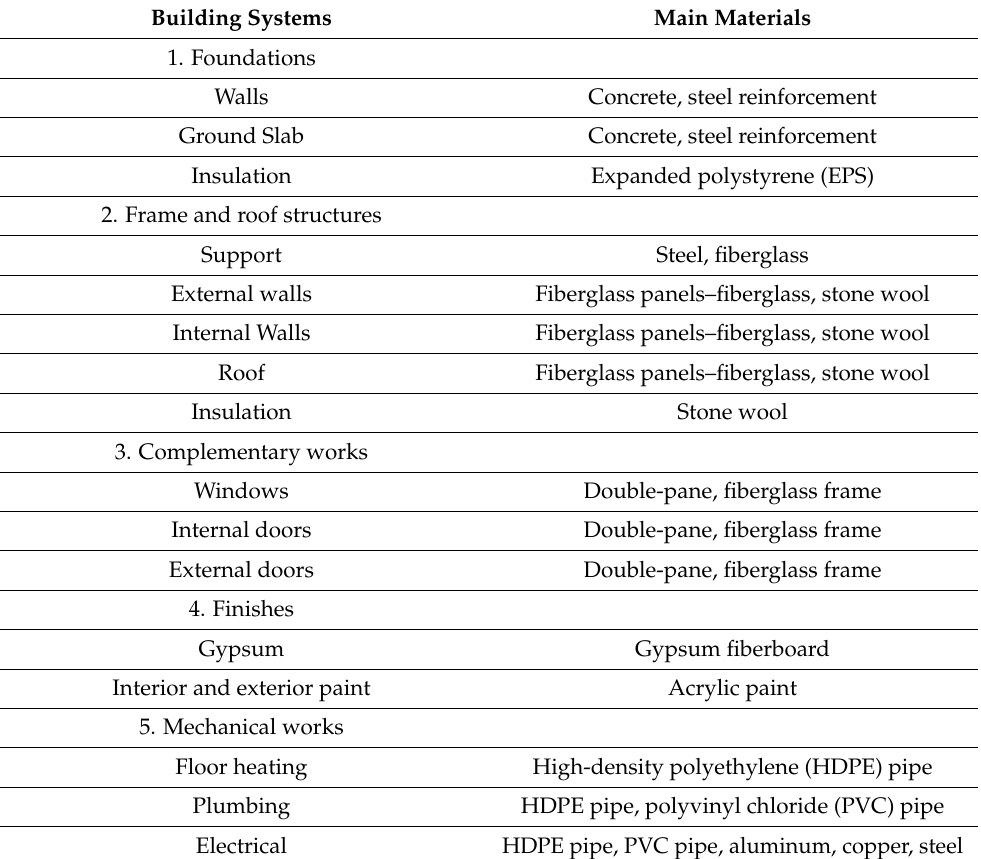
Table 2. Five main building systems of the fiberglass house, split by the main components of each, along with the main materials of each component.